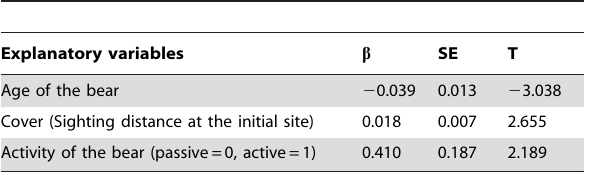
Table 2. Results from the linear mixed model for flight initiation distance